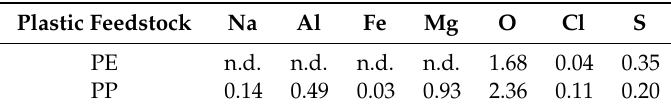
Table 2. Textural properties and acidity of different catalysts. BET: Brunauer ‐ Emmett ‐ Teller; n.a.: not applicable. Experiment